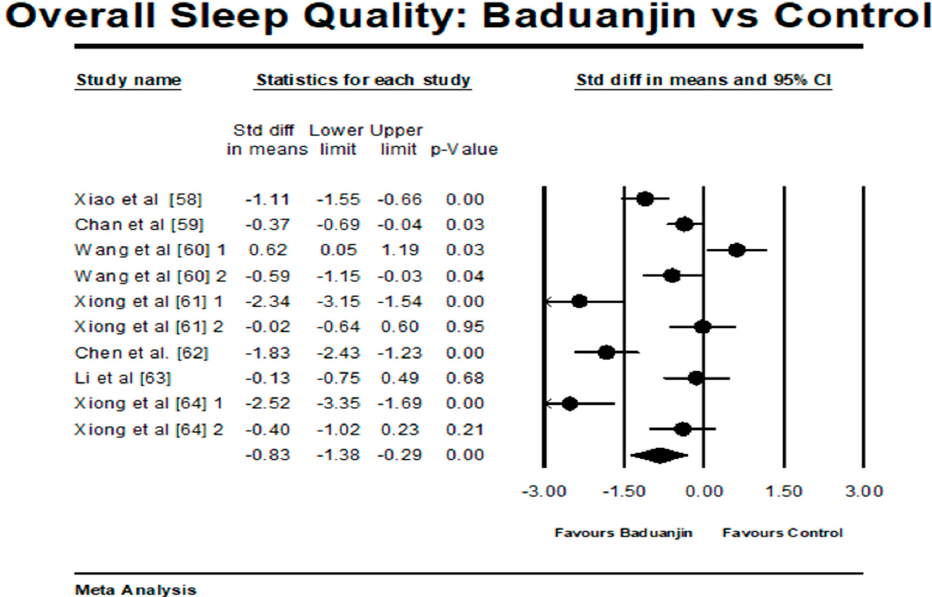
Figure 4. Effect of Baduanjin on overall sleep quality across all studies selected; Wang et al. [60] 1 = Baduanjin vs. LiuZijue; Wang et al. [60] 2 = Baduanjin vs. no training; Xiong et al. [61] 1 = Baduanjin + acupuncture vs. acupuncture; Xiong et al. [61] 2 = Baduanjin vs. acupuncture; Xiong et al. [64] 1 = Baduanjin + acupuncture vs. acupuncture; Xiong et al. [64] 2 = Baduanjin vs. acupuncture). 1 is referring to the first comparison, which is Baduanjin vs. Liuzijue; 2 for the second comparison in the same study.